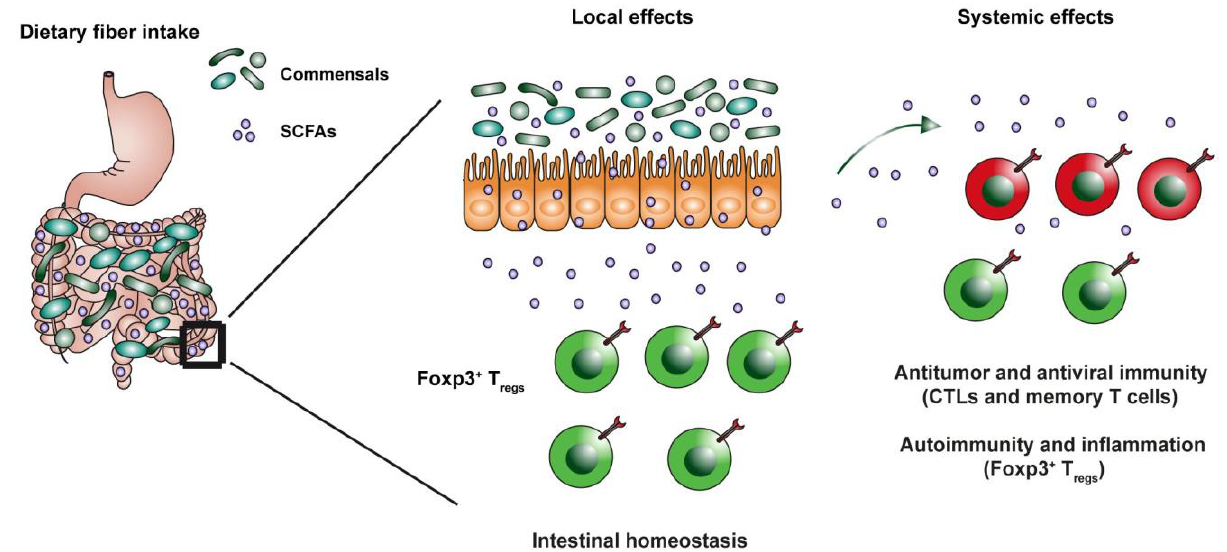
Figure 1. Bacterial fermentation of dietary fiber in the intestinal lumen leads to generation of SCFAs such as acetate, propionate, butyrate and pentanoate. Microbial SCFAs are potent signaling molecules that are capable of crossing the epithelial barrier and of acting directly on immune cells in the lamina propria. SCFAs promote the epithelial barrier function, local expansion of colonic Tregs and mucosal IgA responses. Microbiota-derived molecules such as SCFAs are also able to reach the circulation and to influence the host health by strengthening anti-viral and anti-cancer T cell responses as well as suppressing autoimmunity and inflammation in peripheral tissues.